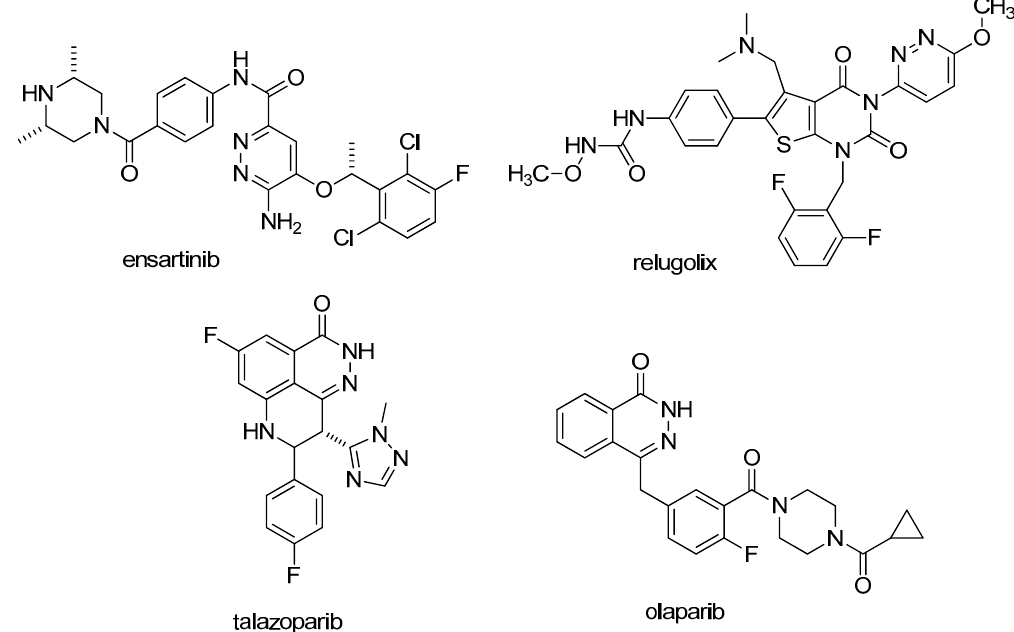
Figure 1. Pyridazine derivatives under clinical development: ensartinib, relugolix, talazoparib, and